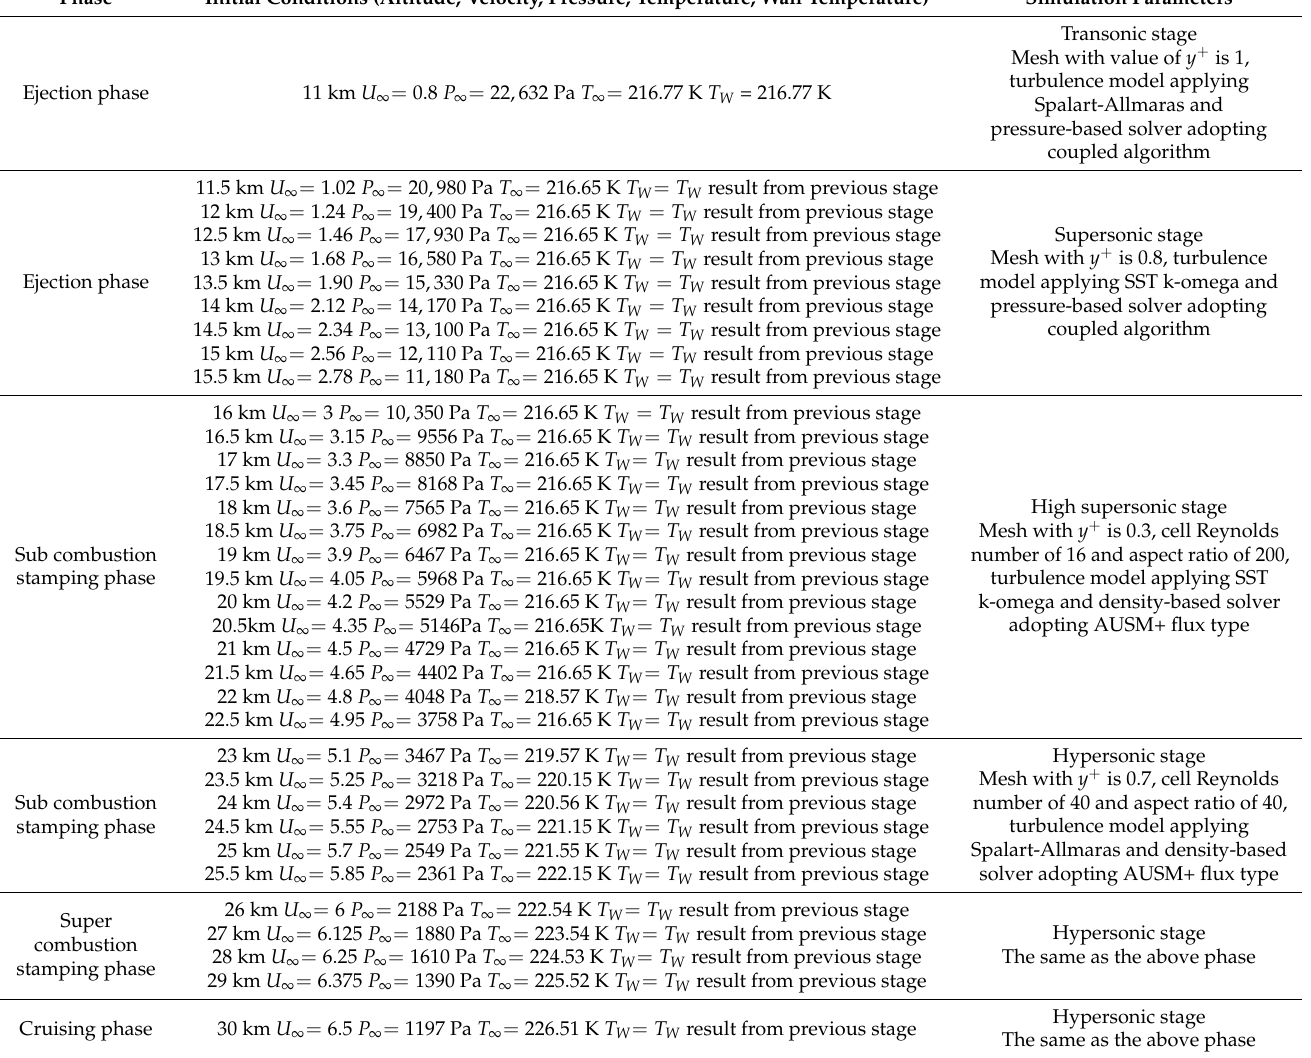
Hypersonic stage The same as the above